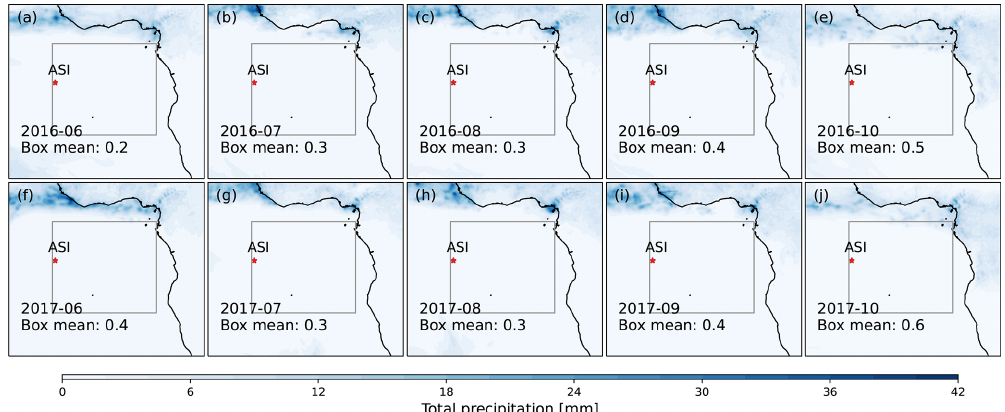
Figure 7. Same analysis as in Fig. 6, but with